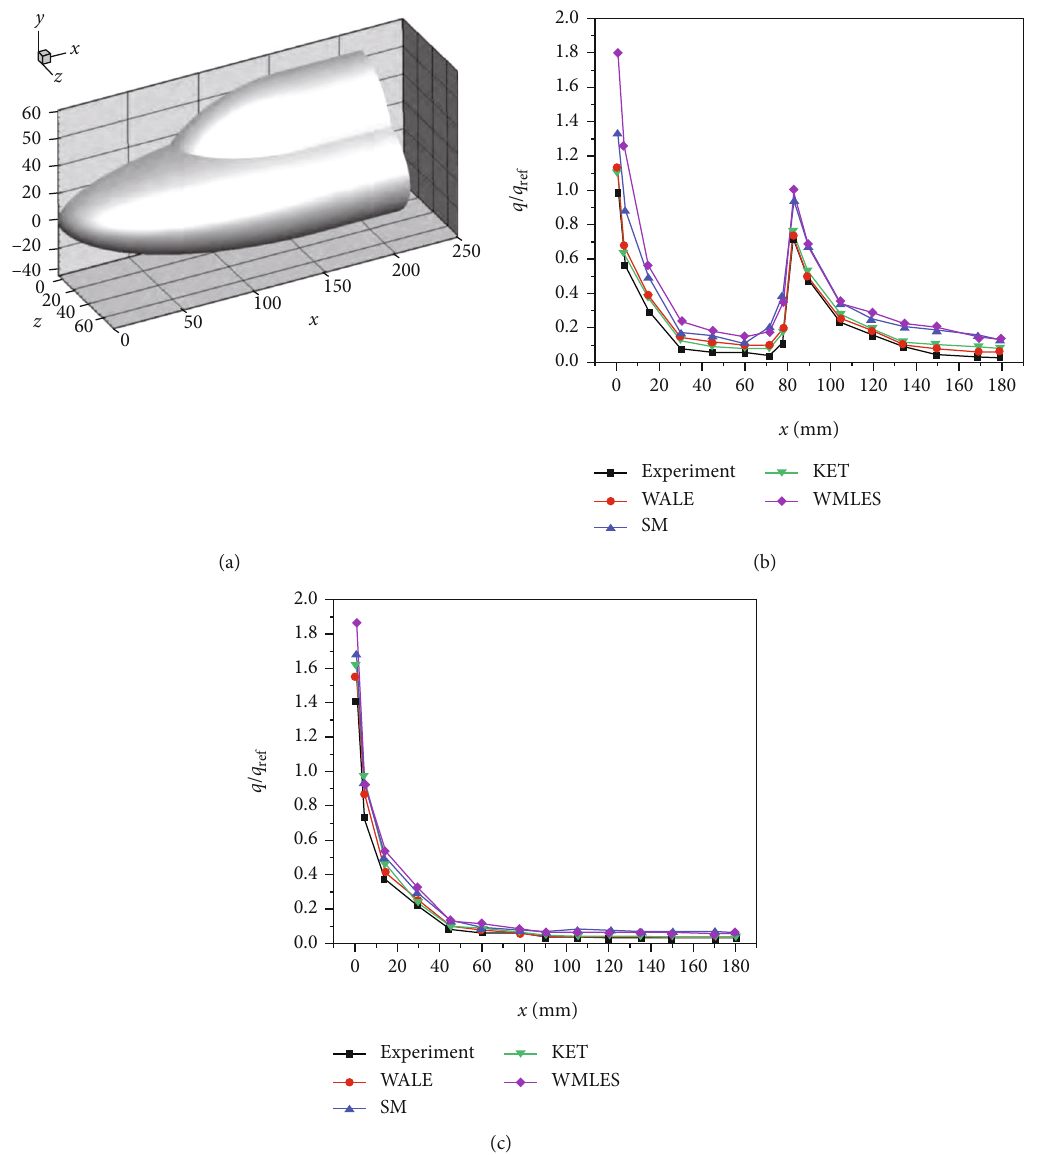
Figure 5: Validation of SGS models: (a) double ellipsoid model; (b) heat fl ux on windward meridian; (c) heat fl ux on leeward